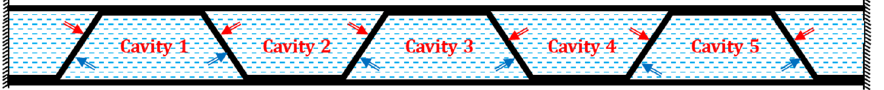
Figure 2. The vibro-acoustic coupling between the structure and trapezoidal acoustic cavities.